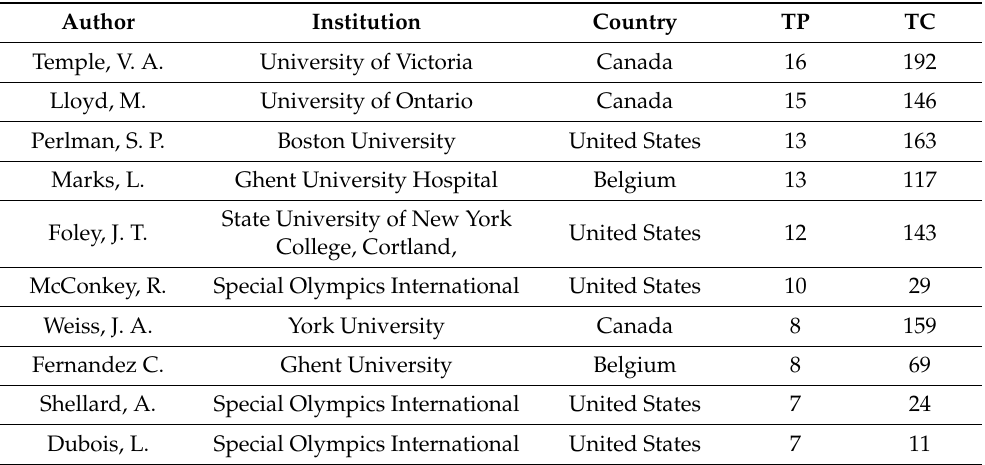
Table 1. The top 10 most prolific authors of Special Olympics publications between 1978 and 4 March